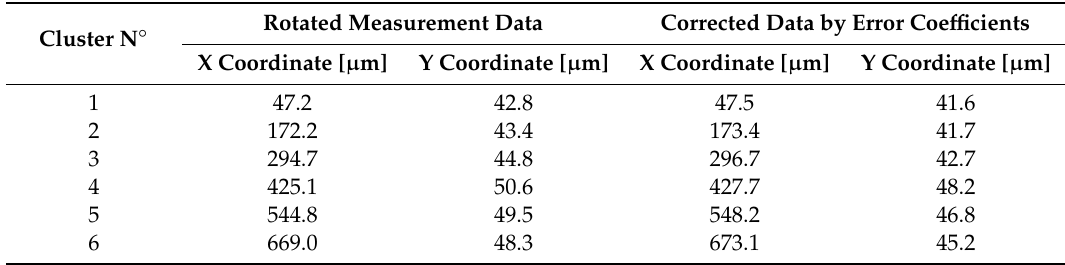
Table 5. The aligned and corrected measurement data.